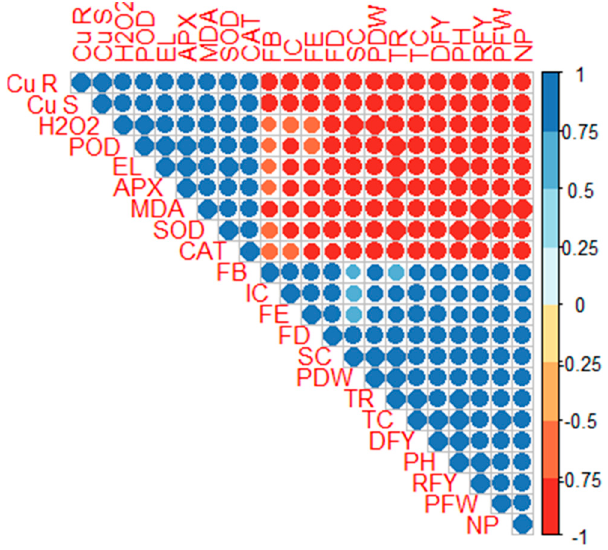
Figure 5. Correlation between Cu uptake and growth attributes of C. capsularis . Cu R (Cu concentration in the roots), Cu S (Cu concentration in the shoots), H 2 O 2 (hydrogen peroxide contents), POD (peroxidase activity), EL (electrolyte leakage), APX (ascorbate peroxidase activity), MDA (malondialdehyde contents), SOD (superoxidase activity), CAT (catalase activity), FB (fibre breaking strength), IC (intercellular CO 2 ), FE (fibre elongation rate), FD (fibre diameter), SC (stomatal conductance), PDW (plant dry weight), TR (transpiration rate), TC (total chlorophyll), DFY (degummed fibre yield), PH (plant height), RFY (raw fibre yield), PFW (plant fresh weight) and NP (net photosynthesis).